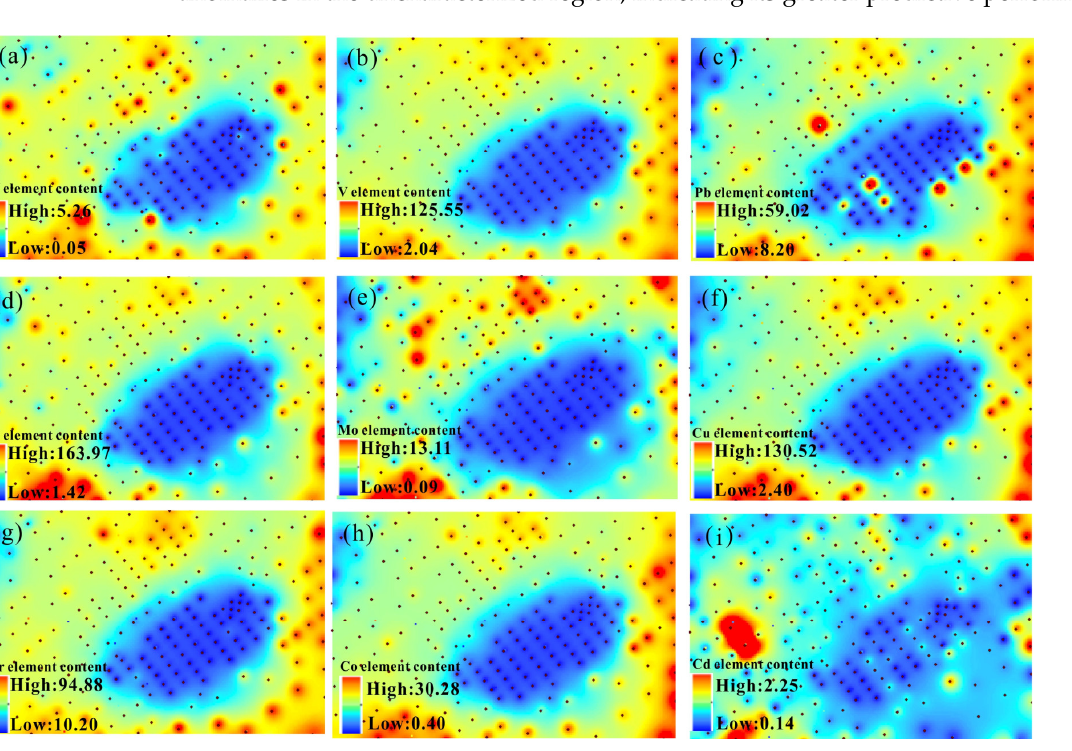
Figure 4. ( a ) A comparison of anomalies delineated using the singularity method ( a ) and the tradi- tional statistical method ( b ). The dot in the figure indicates the position of the sampling point, and the black area is the determined abnormal area.